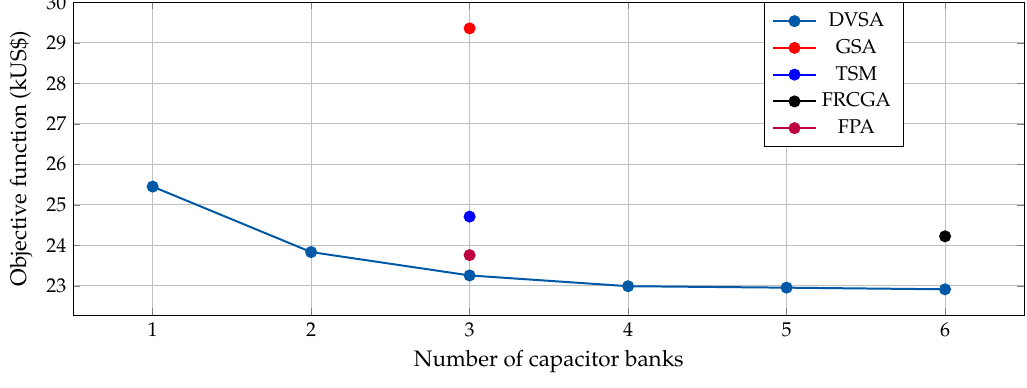
Figure 6. Impact of the number of capacitor banks in the final operation